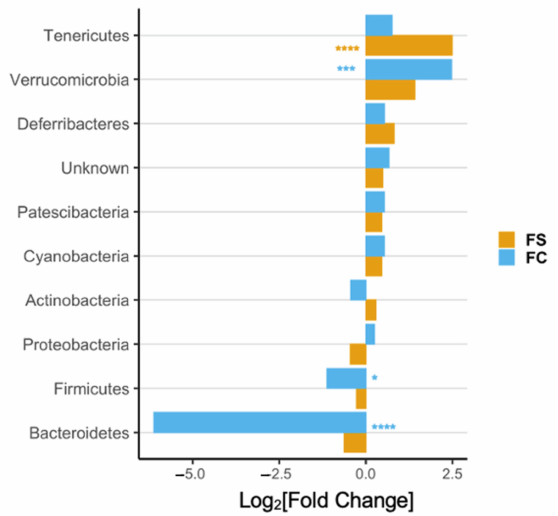
Figure 2. ( D ). Differential phyla abundance, represented as log 2 [Fold Change] from CON for each iron treatment group ( n = 27–29/group, 3 litters/group); phyla are ordered by magnitude of change and bars are labeled with color according to iron treatment